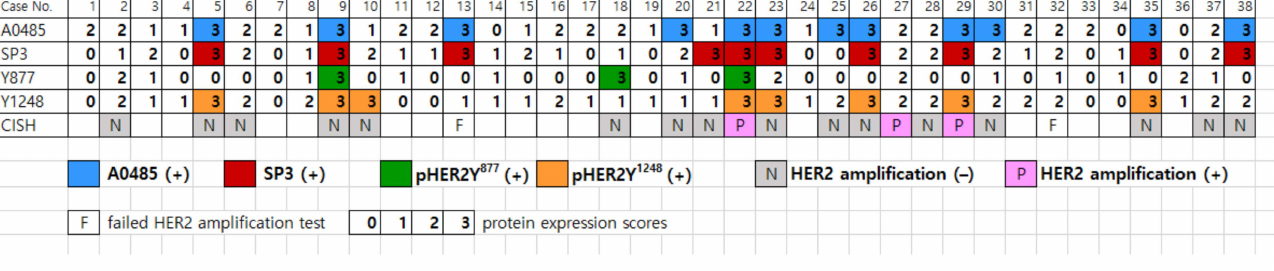
Figure 3. Positivity (score 3) for the four HER2 antibodies (A0485, SP3, pHER2Y 877 , and pHER2Y 1248 ) and HER2 amplification by CISH in peritoneal disseminated cancer cells of